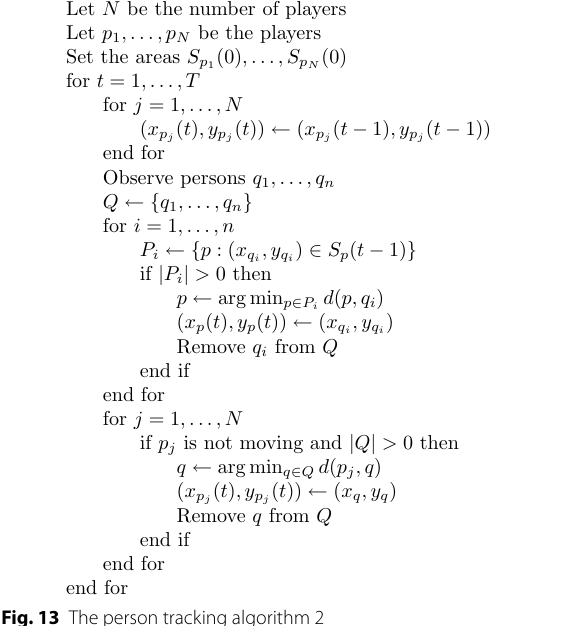
Table 1 Specifications of the mobile robot